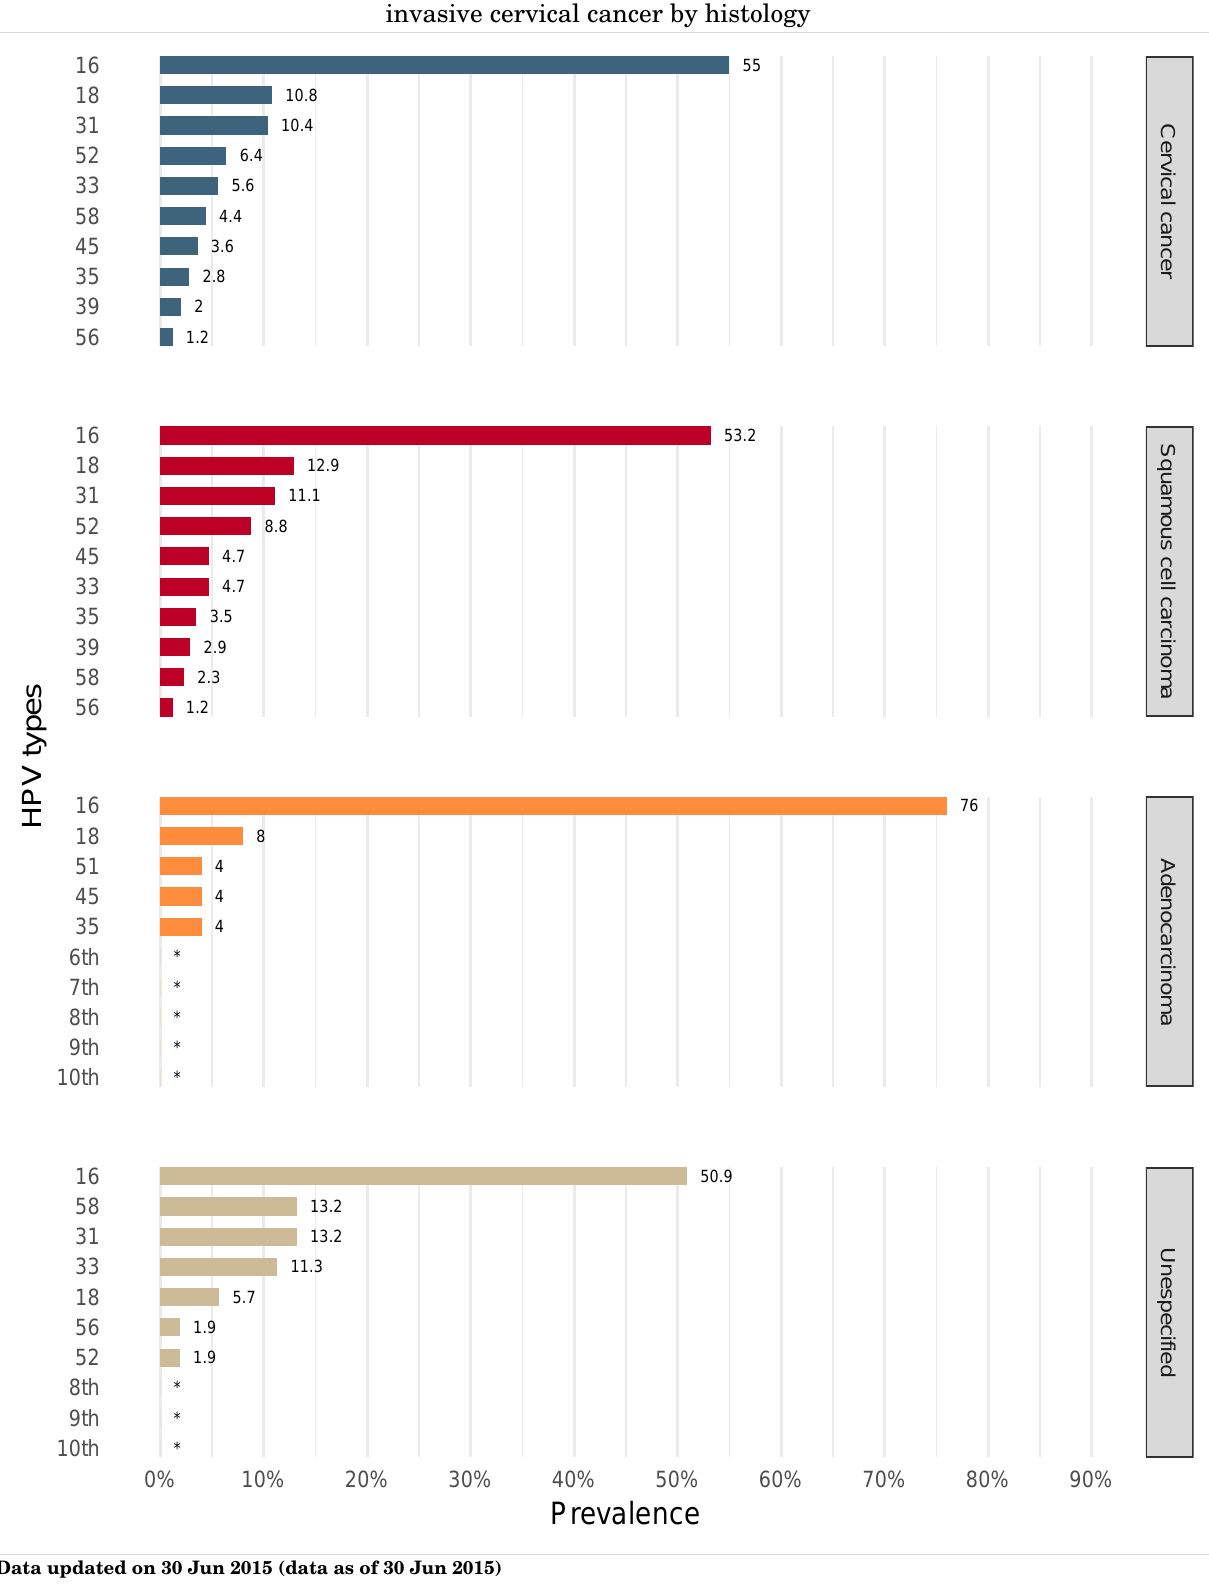
Figure 61: Comparison of the ten most frequent HPV oncogenic types in Peru among women with invasive cervical cancer by